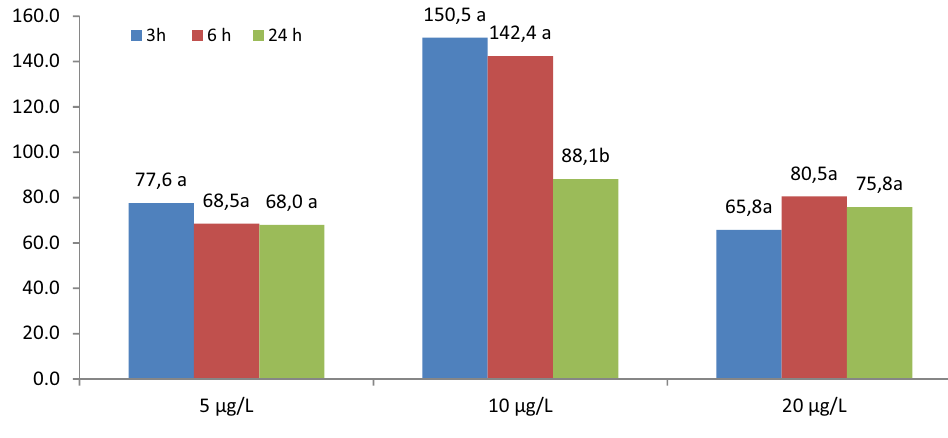
Figure 4. Value of the TM parameter depending on the concentration and exposure